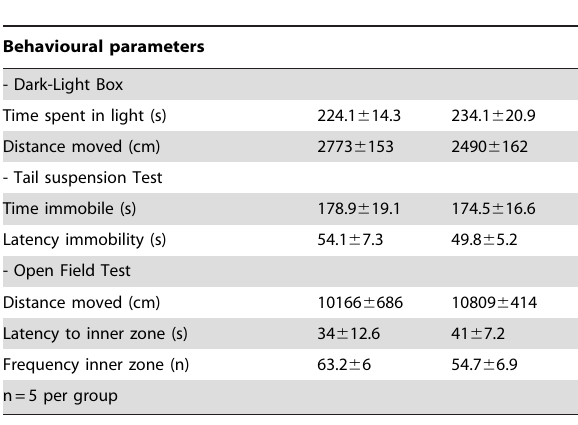
Table 5. Emotionality parameters of wild type (WT) and Gpr12 deficient (Gpr12 KO) mutant mice – Australian study.